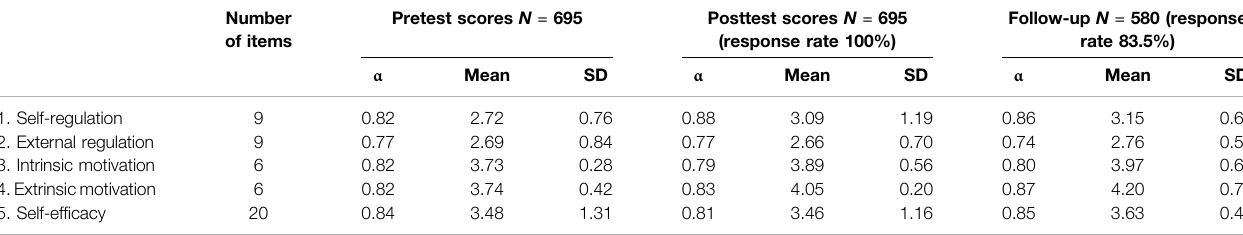
TABLE 3 | Reliability ILS (Slaats, 1997) and STPQ (Van Meeuwen et al., 2012). Number of items